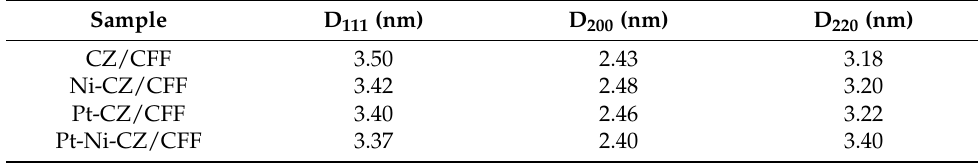
Table 1. The crystallite size (D) for CeZrO 2 in (111), (200) and (220) direction.